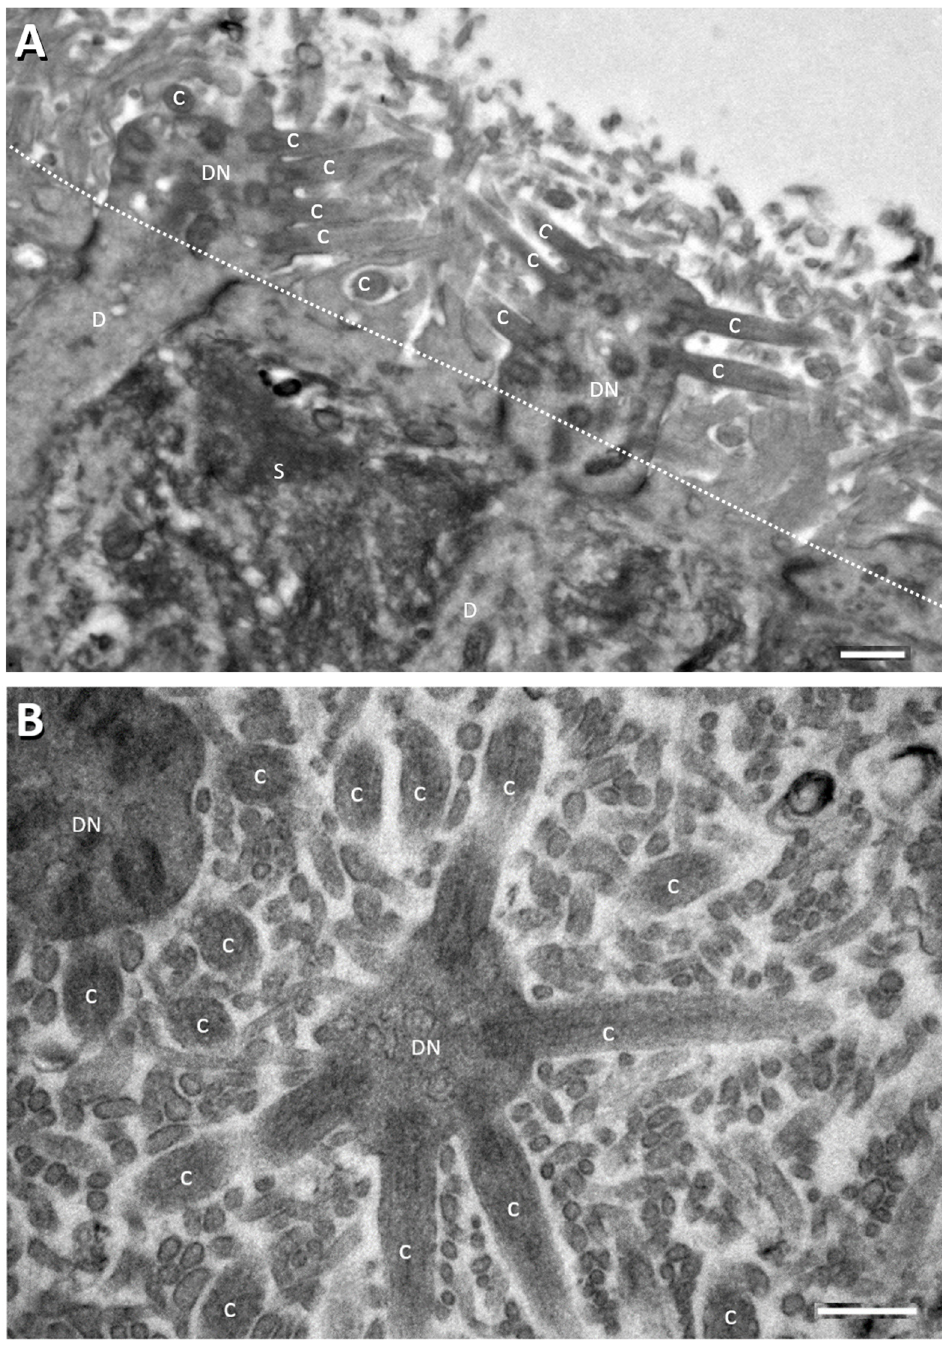
Figure 1. Electron micrographs showing perpendicular ( A ) and tangential/oblique section ( B ) of the apical part of the rat OE. Dotted line in panel A denotes sustentacular cell (S) apical surface from which the long thin sustentacular-cell microvilli protrude into the nasal cavity for about 2–3 µm. ORN dendritic knobs (DN) and cilia (C) at apical ends of ORN dendrites (D) are mostly found among the sustentacular microvilli (most of the unlabeled small profile structures in ( B ) and in area above the dotted line in ( A ). Human OE is similarly organized [52–54]. Scale bars = 0.5 µm.